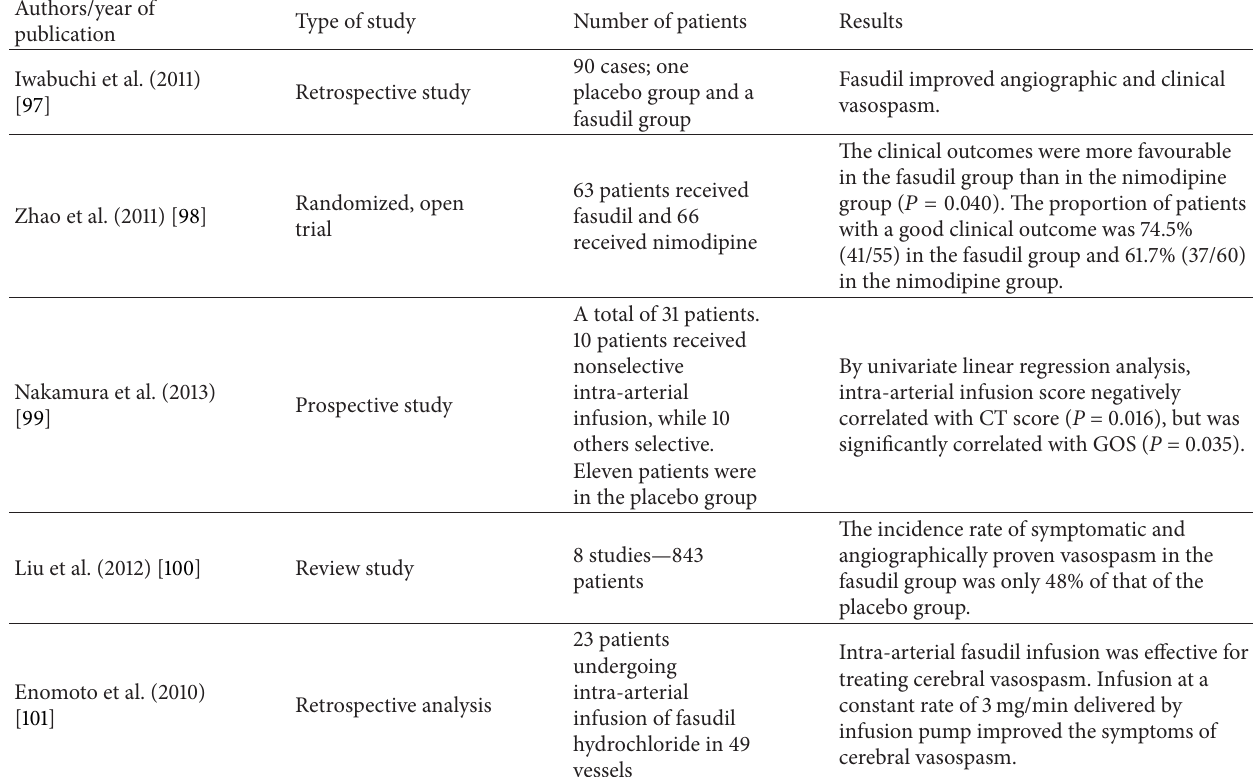
Table 4: Summary of clinical data regarding fasudil in the management of cerebral